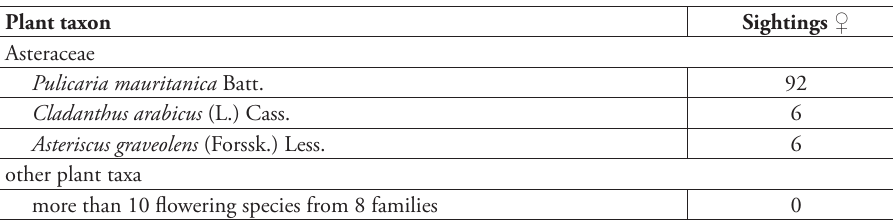
Table 1. Sightings of flower visiting females of Quartinia major at the flowers of various plant taxa at two localities in Morocco. Sightings were made during random transect investigations, point observations and unsystematically